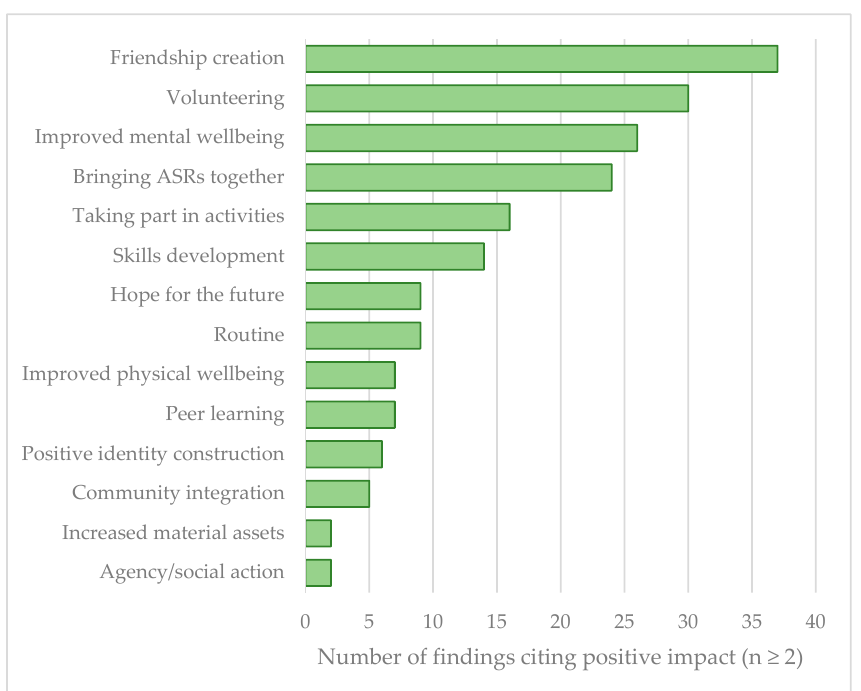
Figure 3. Semi-Formal Social Protection Provision—Positive Impacts Reported.